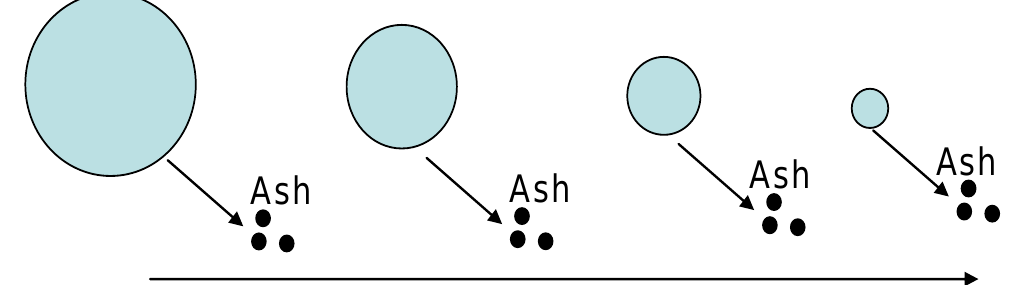
Figure 24. Particle Time History in Fluidized